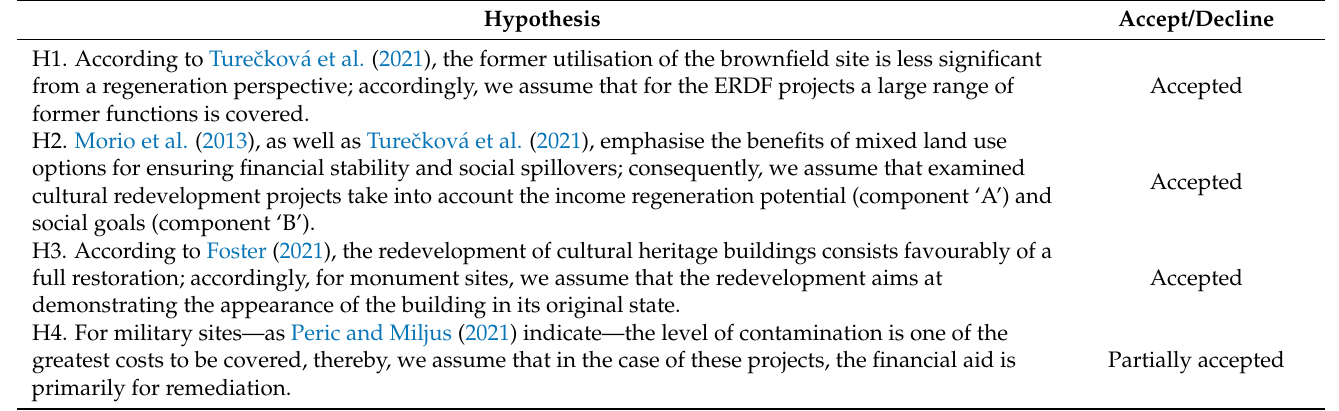
Table 8. Confirmation of the